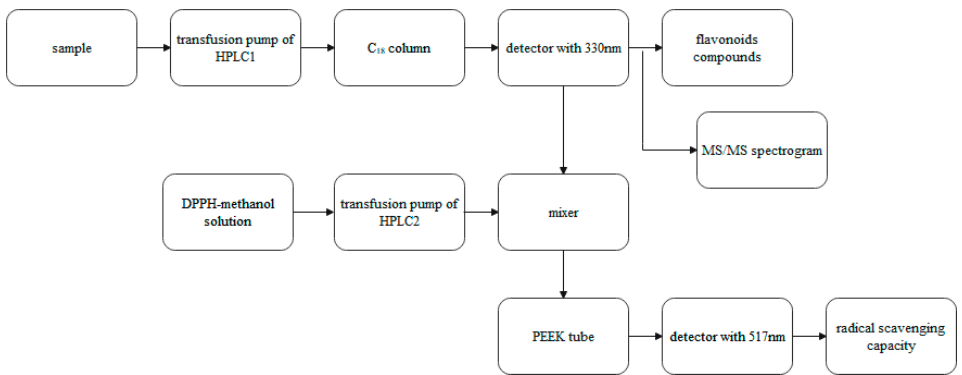
Figure 7. The flow chart of online HPLC-DPPH screening